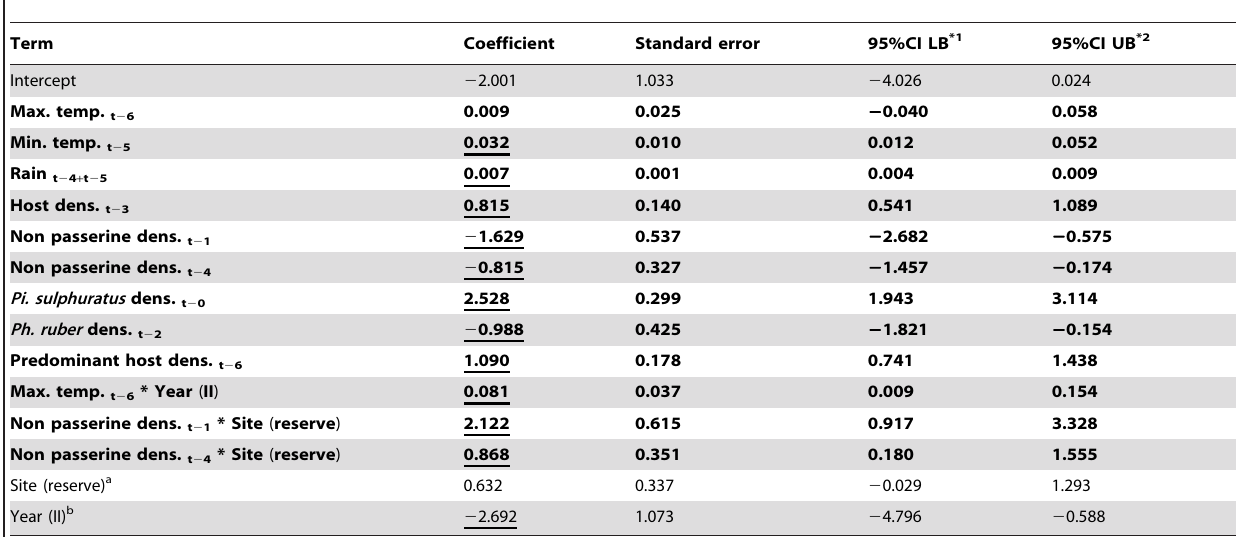
Table 4. Parameters of the best models describing the community level factors associated with mean P. torquans abundance in a given week.